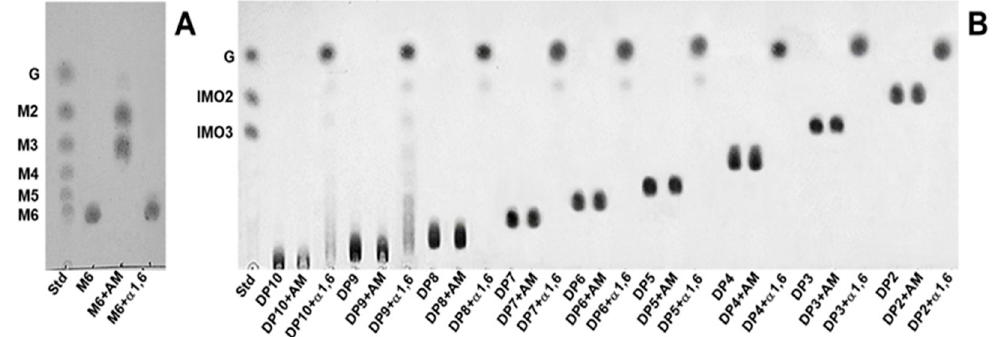
Figure 5. TLC of enzymatic hydrolysis of maltohexaose (M6) ( A ) and each IMO with degree of polymerization (DP) 2–10 produced from B. subtilis strain AP-1 ( B ) by the action of α -amylase (AM) and oligo- α -1,6-glucosidase ( α 1,6). Glucose (G), maltooligosaccharides (M2–M6), isomaltose (IMO2) and isomaltotriose (IMO3) were used as standards (shown on the left-hand side of each image). Table 1. Reducing sugar content and hydrolysis degree of IMOs during the oral, gastric and intestinal phases of